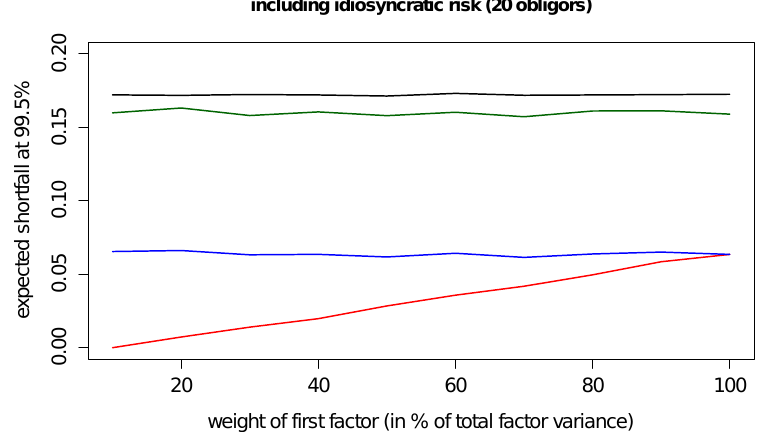
Figure 4. Risk attribution including idiosyncratic risk from 20 obligors. The average approximation error is 7.1%, with the aggregated risk contributions of 0.160 compared to the total risk of